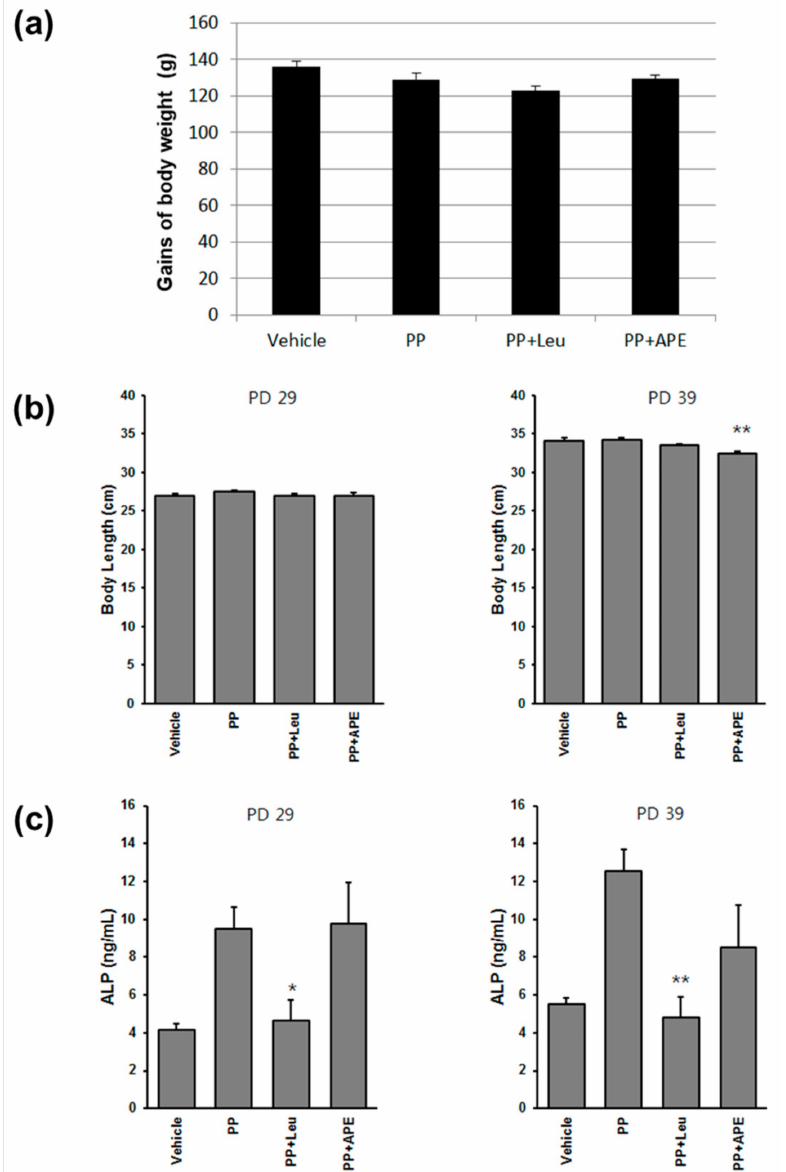
Figure 3. Effect of APE on the growth rate of experimental rats. ( a ) The body weight gain in rats of different groups on PD 39. ( b ) Effect of APE on body length of rats in the PP model. ( c ) The serum ALP levels in rats of different groups. * p < 0.05; ** p < 0.01, compared to the PP